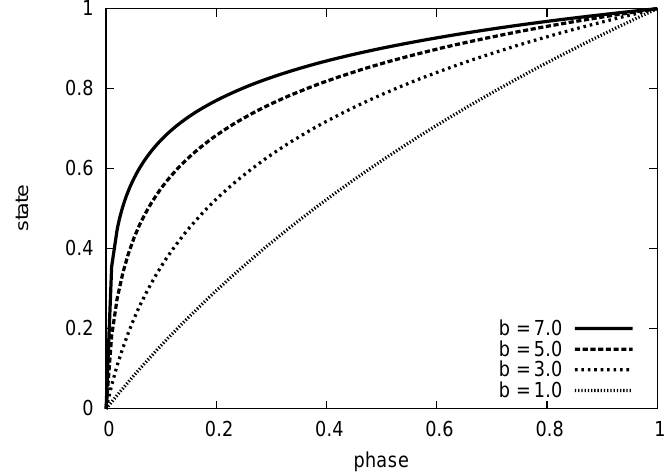
Figure 1. Effect of changing b on relationship between state and